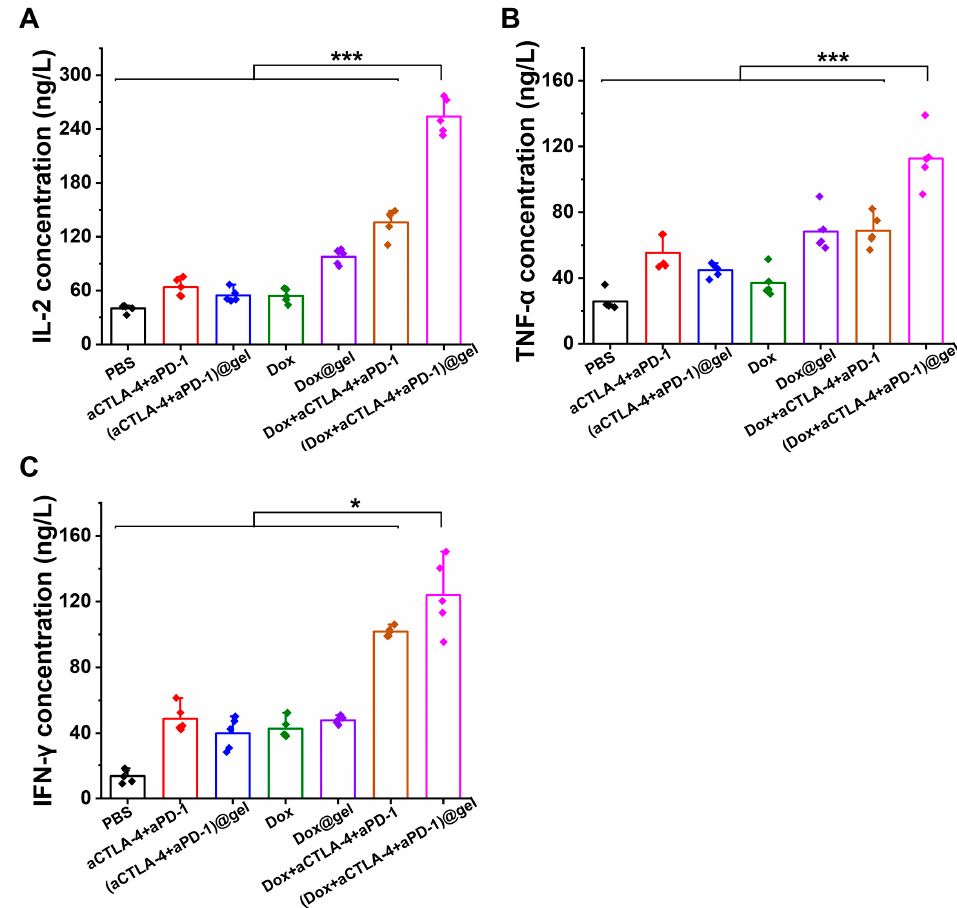
Figure 6. Pro-inflammatory cytokine concentration in the serum of various groups after treatment for 14 days. ( A ) The concentration of IL-2 ( n = 5). ( B ) The concentration of TNF- α ( n = 5). ( C ) The concentration of IFN- γ ( n = 5). (* p < 0.05 and *** p < 0.001)